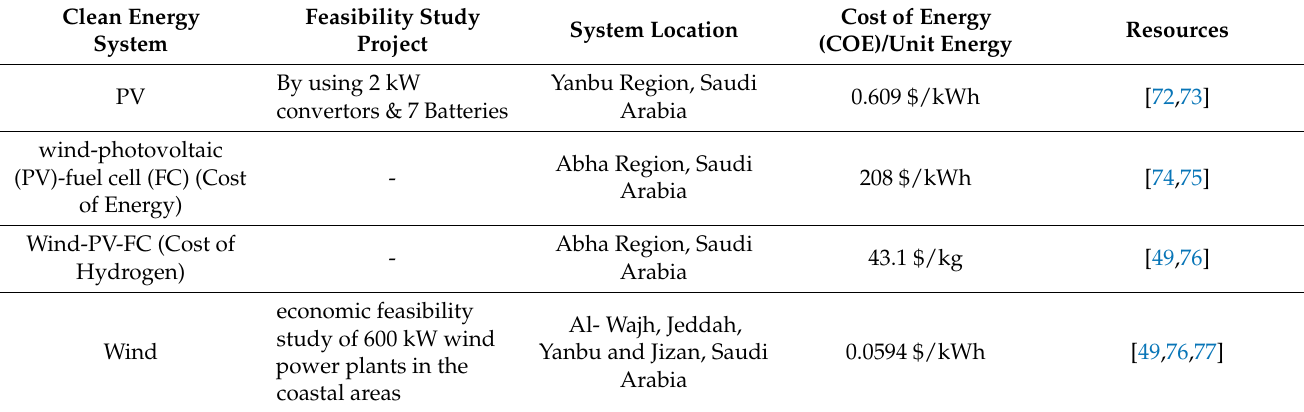
Table A6. Feasibility study projects for clean energy possibility in Saudi